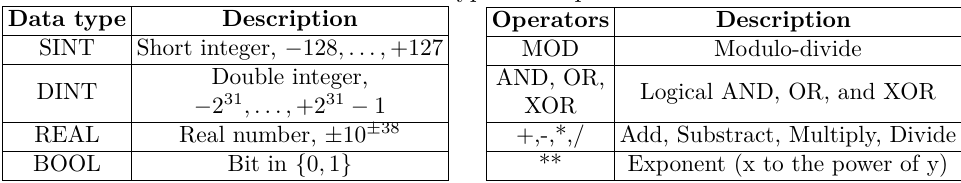
Table 2: Main data types and operators in